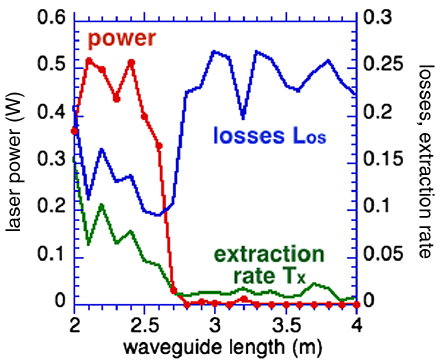
FIG. 10. Numerical simulation of the laser power vs wave- length for CLIO, for various electron beam energies.